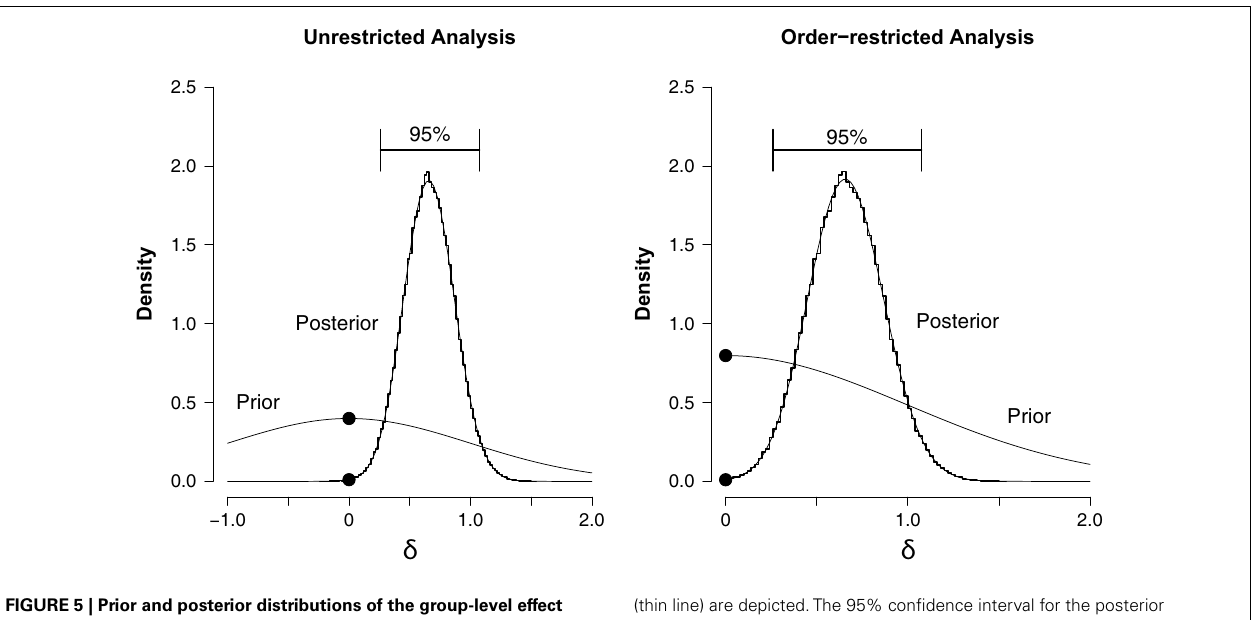
FIGURE 5 | Prior and posterior distributions of the group-level effect size δ for the hierarchical analysis of the surname cities data set. Left panel: unrestricted analysis, right panel: order-restricted analysis. For the prior, the distribution is shown (thin line). For the posterior, a histogram (thick line) and the logspline non-parametric density estimate